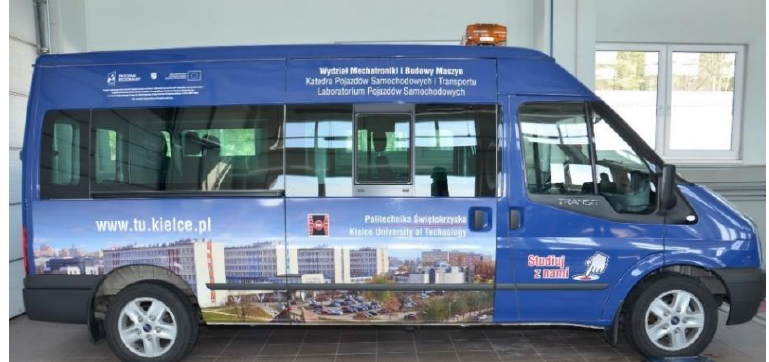
Figure 1. Ford Transit test vehicle.